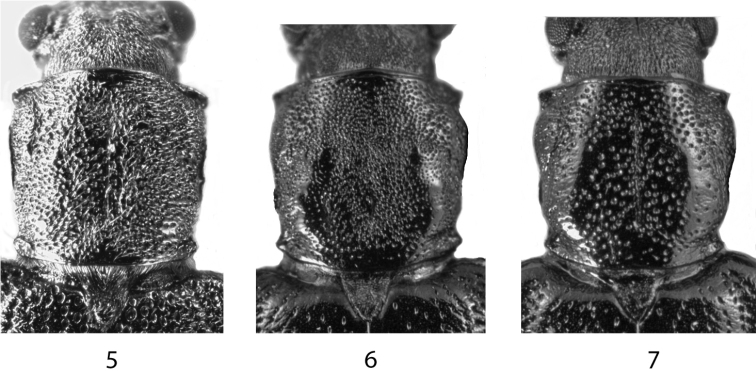
5Donaciaclavareaui, Pronotum 6D.fukiensis, Pronotum densely punctured 7D.fukiensis, Pronotum irregularly punctured.